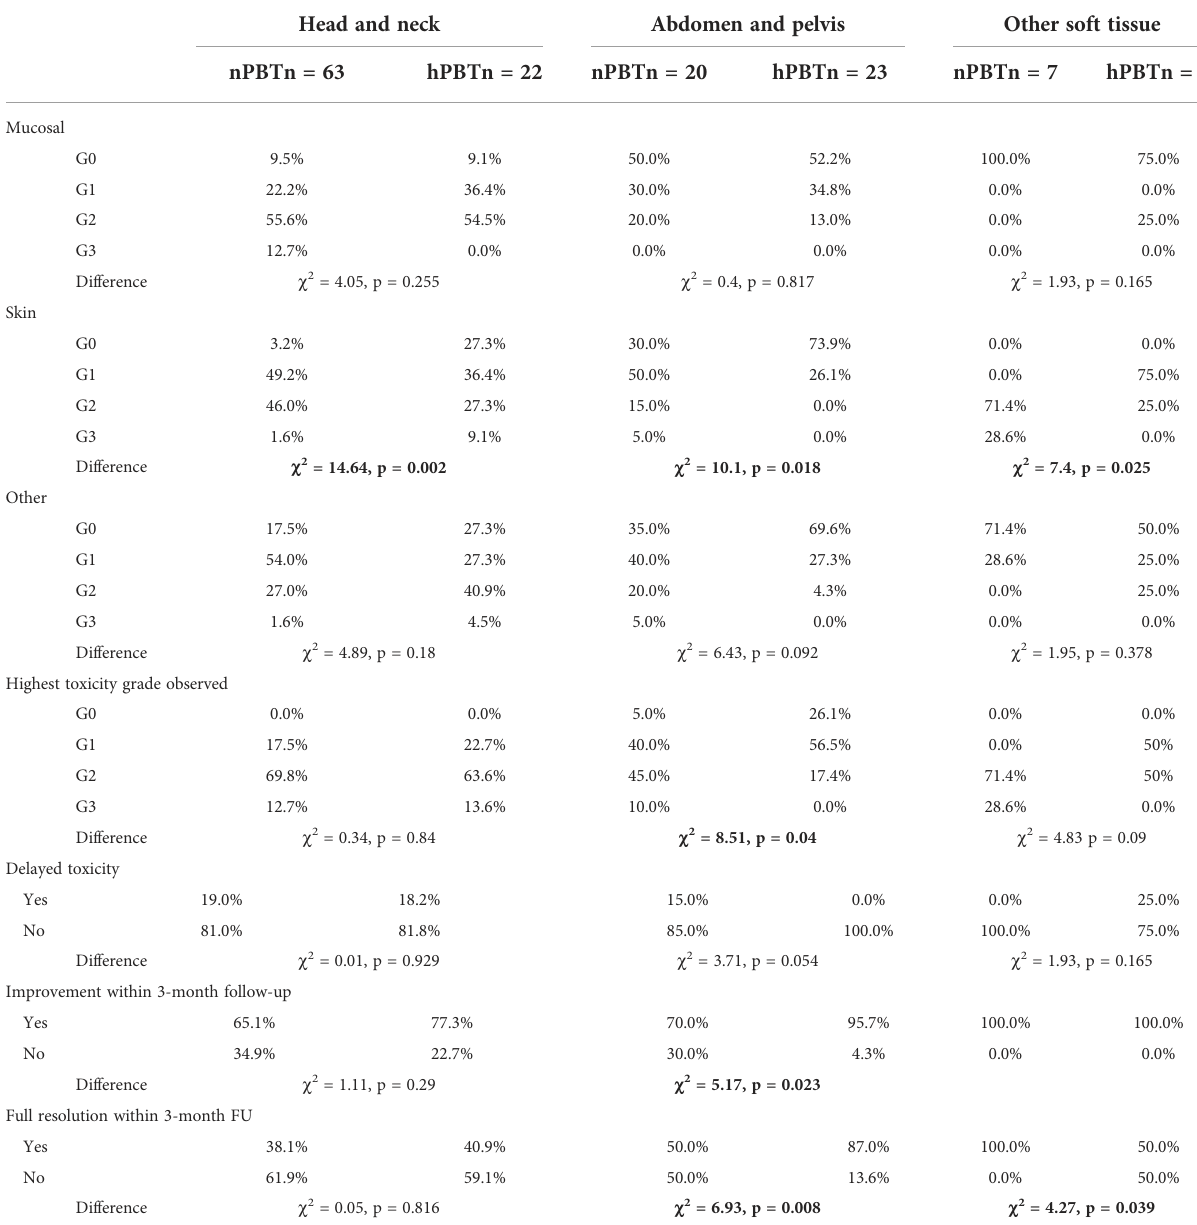
TABLE 3 Distribution of treatment-related toxicity types according to different anatomic sites. Toxicity Treatment site and type of proton therapyFrequency (%) Head and neck Abdomen and